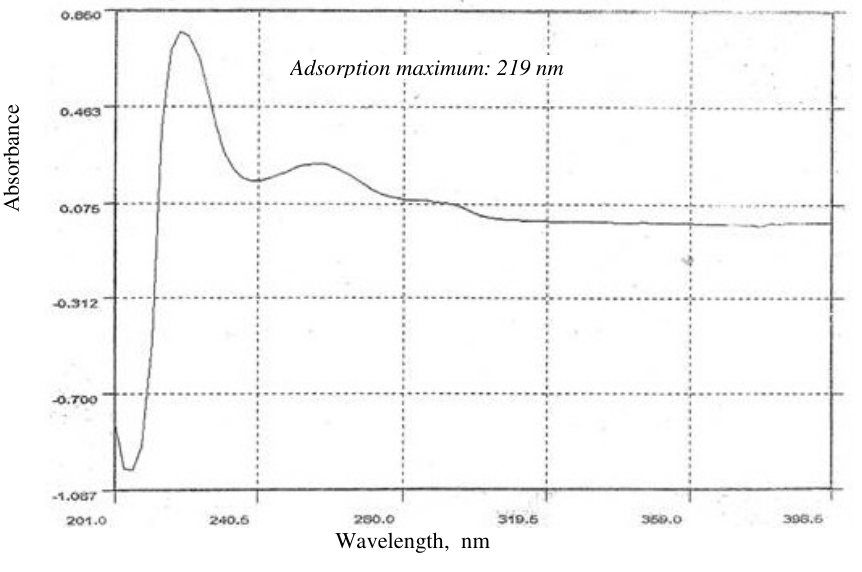
Figure 2. UV spectrum of Aripiprazole in methanol. Table 1. Optical characteristics of proposed method.